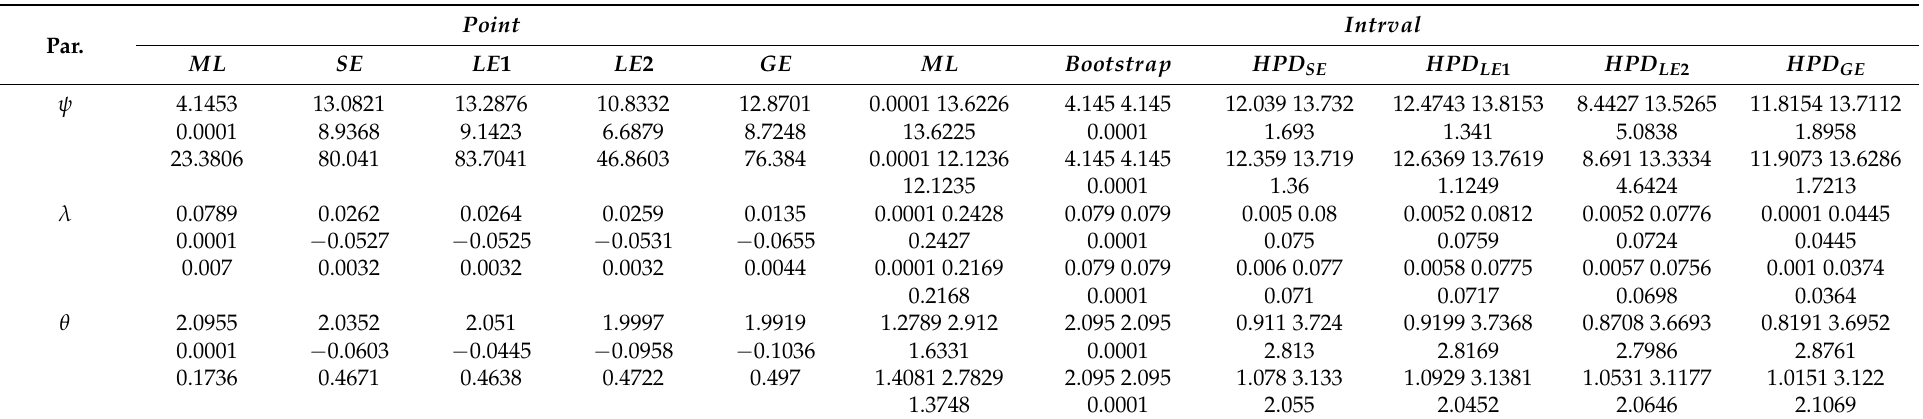
Table 6. The estimation of the parameters ψ , λ , and θ for the low price.